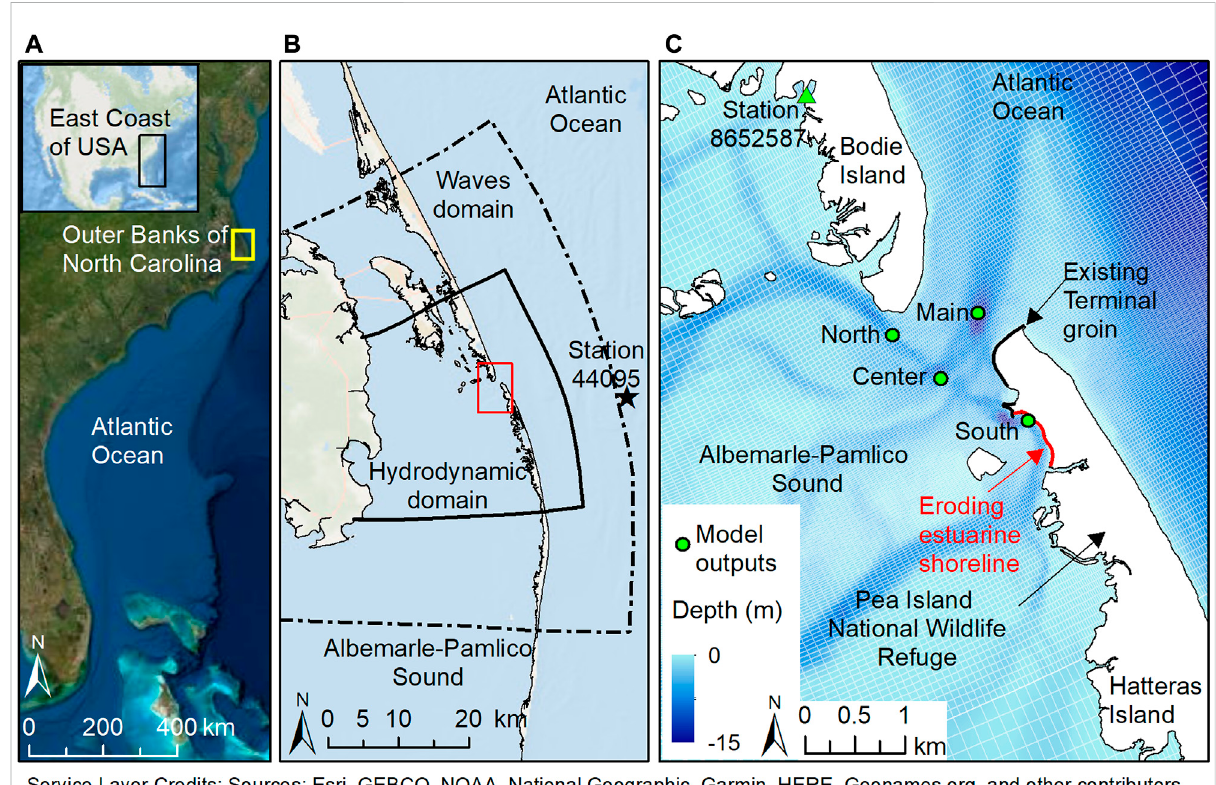
FIGURE 1 Study Area. (A) Location of the Outer Banks of North Carolina relative to the East Coast of the United States. The yellow rectangle indicates the extent of panel (B) . (B) The Outer Banks with the hydrodynamic and wave model domains indicated in black solid and black dashed-dot lines, respectively. The red rectangle indicates the extent of panel (C) . (C) Oregon Inlet, where blue shades indicate depths in meters relative to